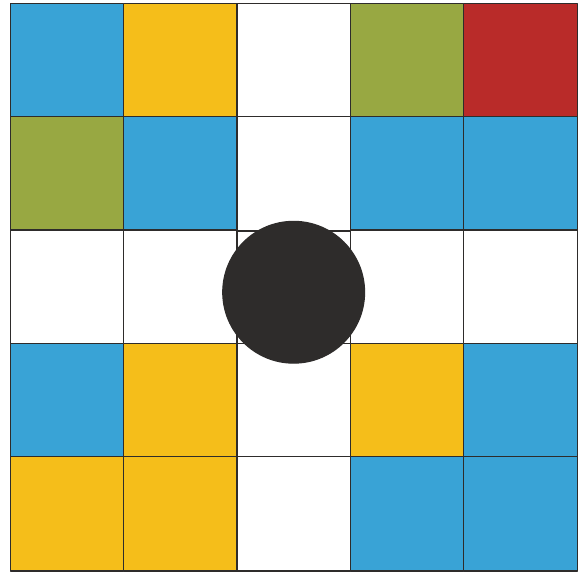
Figure 5: 4 ∗ 4 interpolation window.